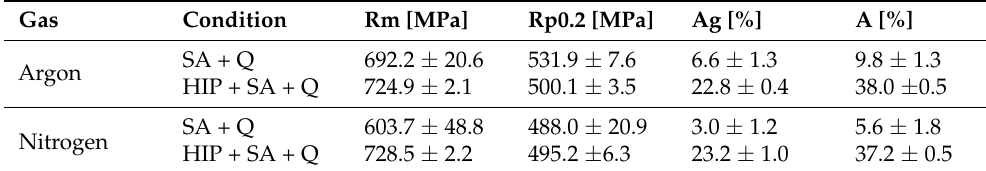
Figure 15. Representative stress–strain curves for L-PBF-processed AISI 318LN under argon and nitrogen protective atmospheres in the SA + Q and HIP + SA + Q conditions. Table 3. Results of quasi-static tensile testing of L-PBF-processed AISI 318LN under a nitrogen and argon